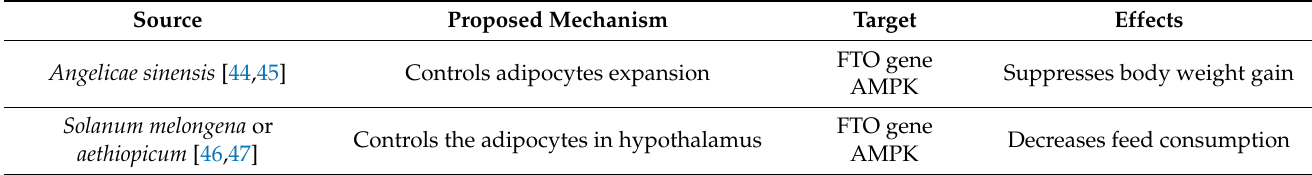
Table 2. Herbs containing nutraceuticals which indirectly activate